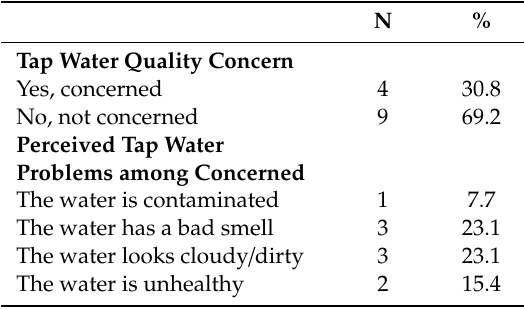
Table 2. Total number and percent of concerned respondents in the neighborhood of Manchester, Houston, Texas, by issue.